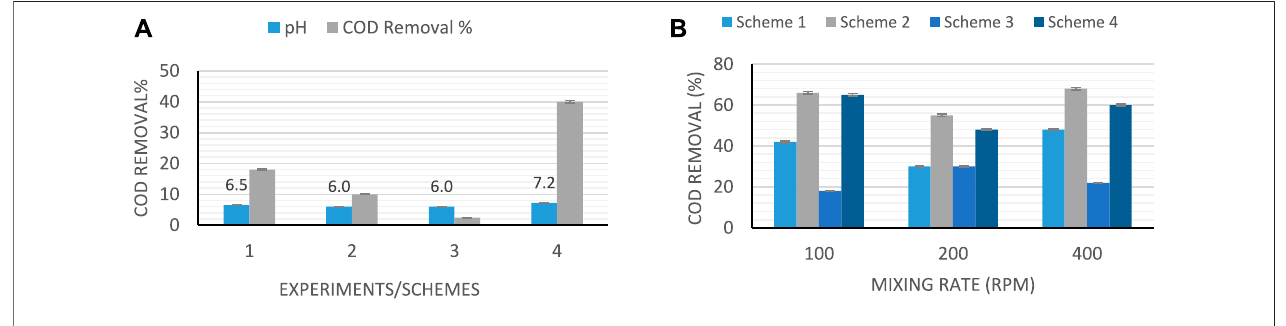
FIGURE 2 | COD removal (%) after each experiment: (A) standing-culture (B) shaking -